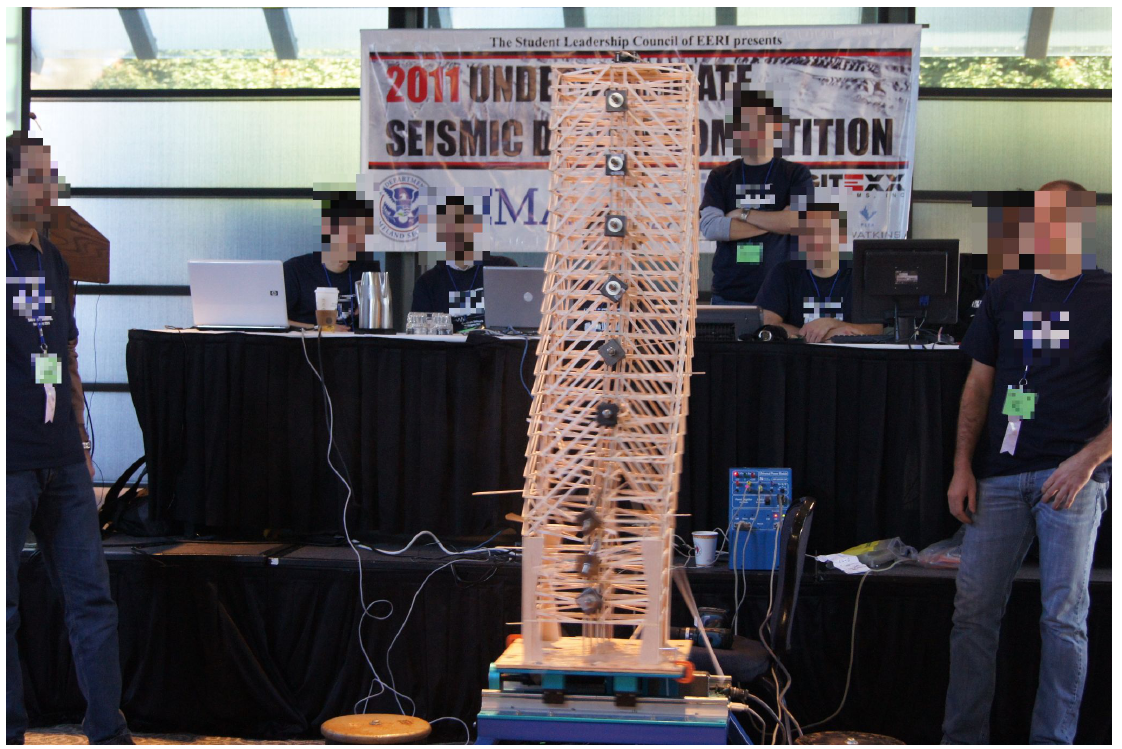
Figure 3. Shake Table II in